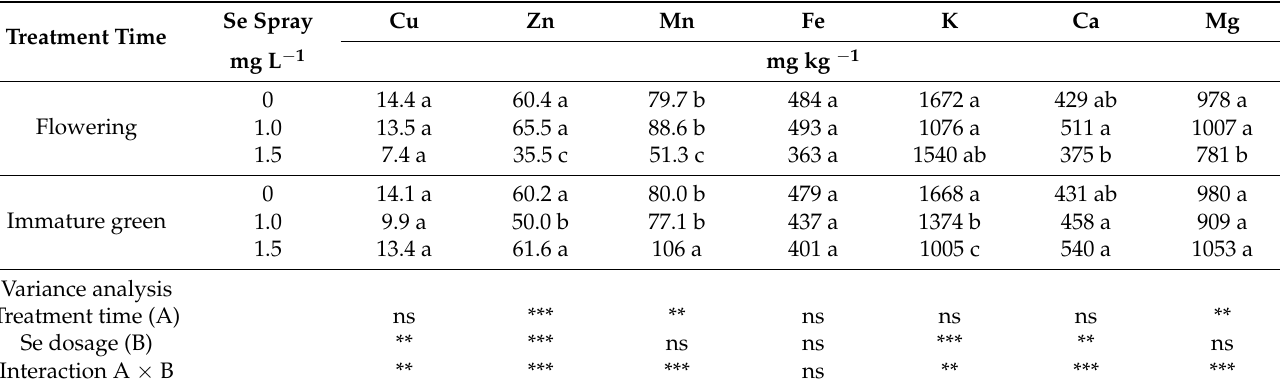
Table 2. Macro- and microelements concentration (mg kg –1 ) in tomato fruit of the first truss treated with sodium selenate (Na 2 SeO 4 ) at different concentrations of Se at FL and fruit IG stages.